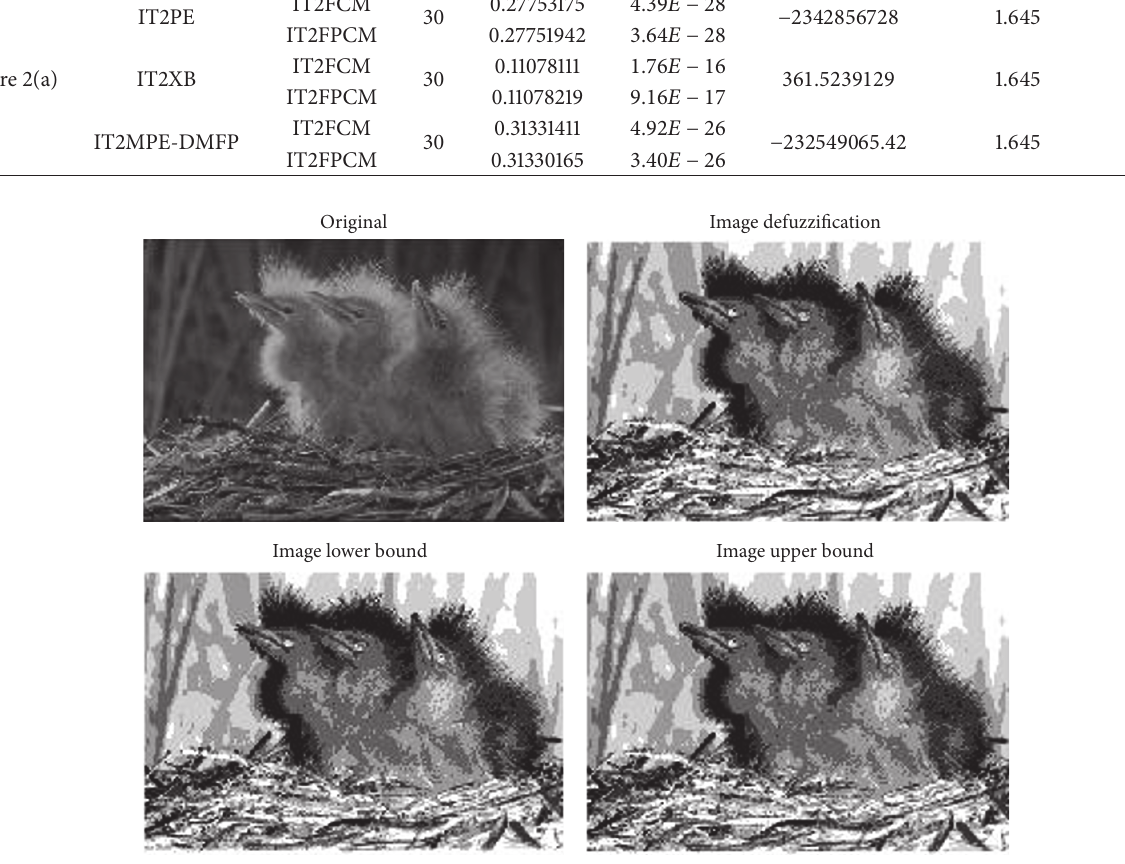
Figure 3: Resulting image clustering performed to Figure 2(a) by the IT2FPCM